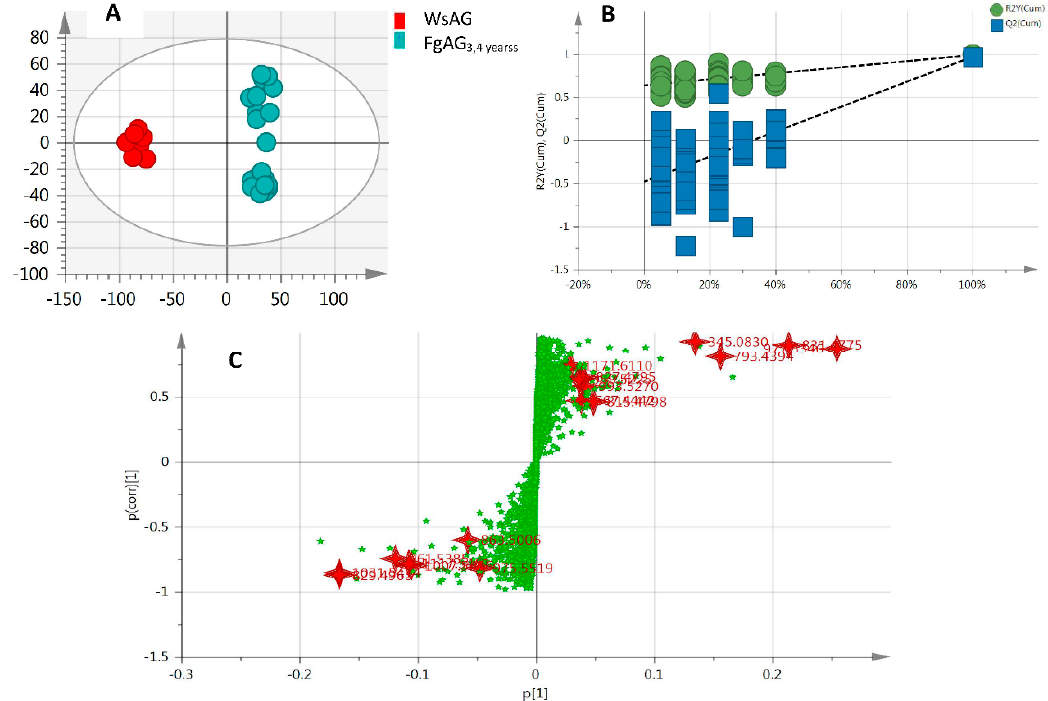
Figure 4. The OPLS-DA ( A ); permutation tests ( B ) and S-plot ( C ) in negative mode.